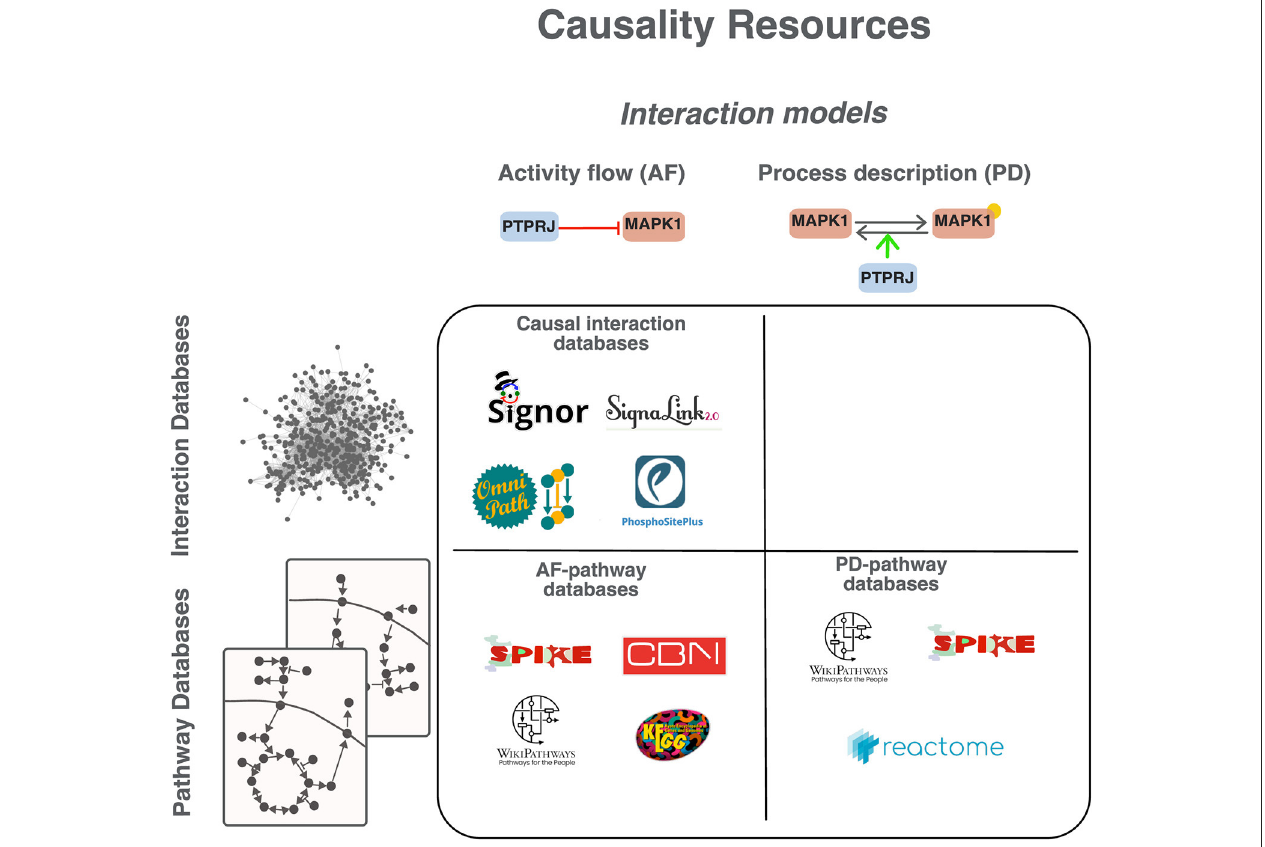
FIGURE 2 | Classification of causality resources. Resources can be grouped according to the model adopted to represent causality in AF or PD (see Figure 1 ) and according to the organization of the information in “interaction databases” or “pathway databases.” In interaction databases relationships are annotated separately and not necessarily in the context of higher-level organizational structures, such as pathways. In “pathway databases” interactions are exclusively shown in the context of the pathway they participate